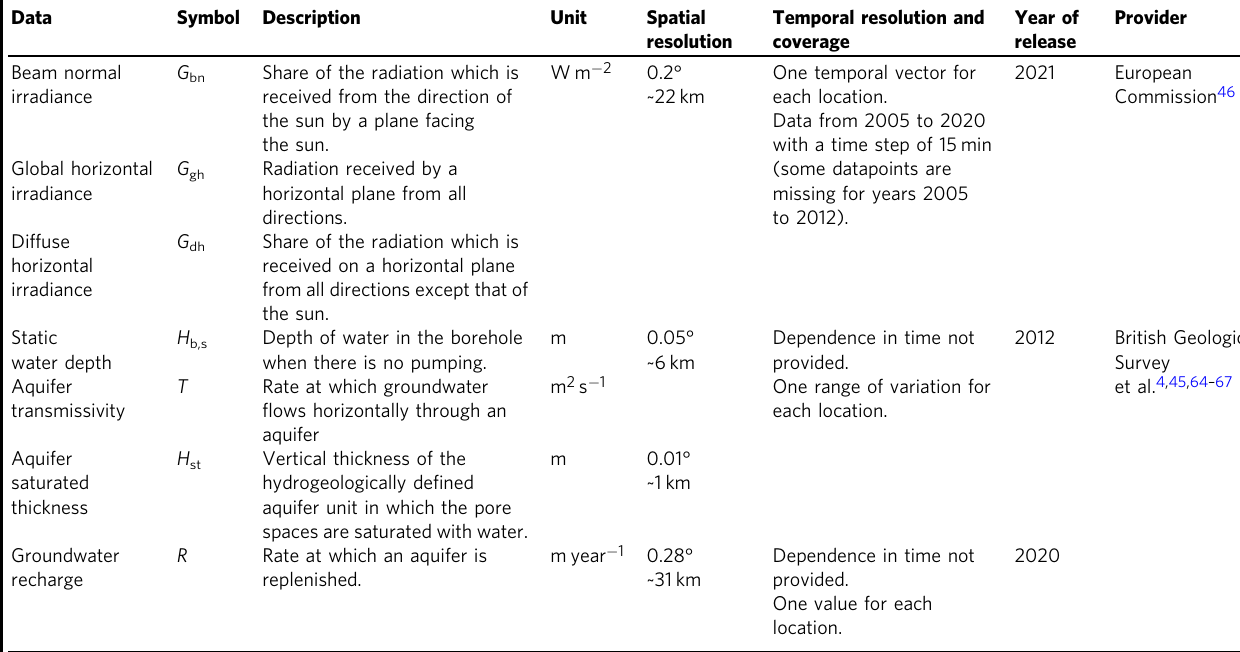
Table 1 Original input location-dependent